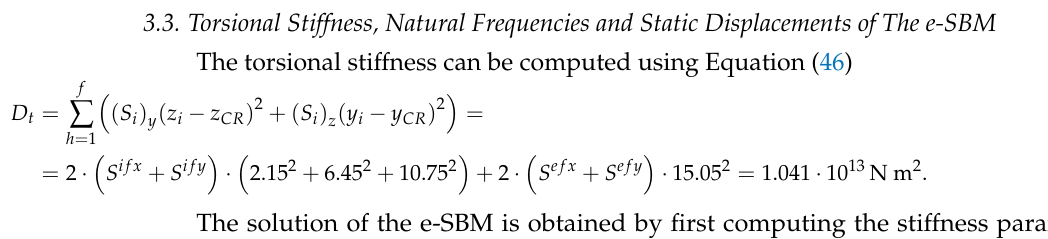
Figure 2. Bracing on the external frame in x